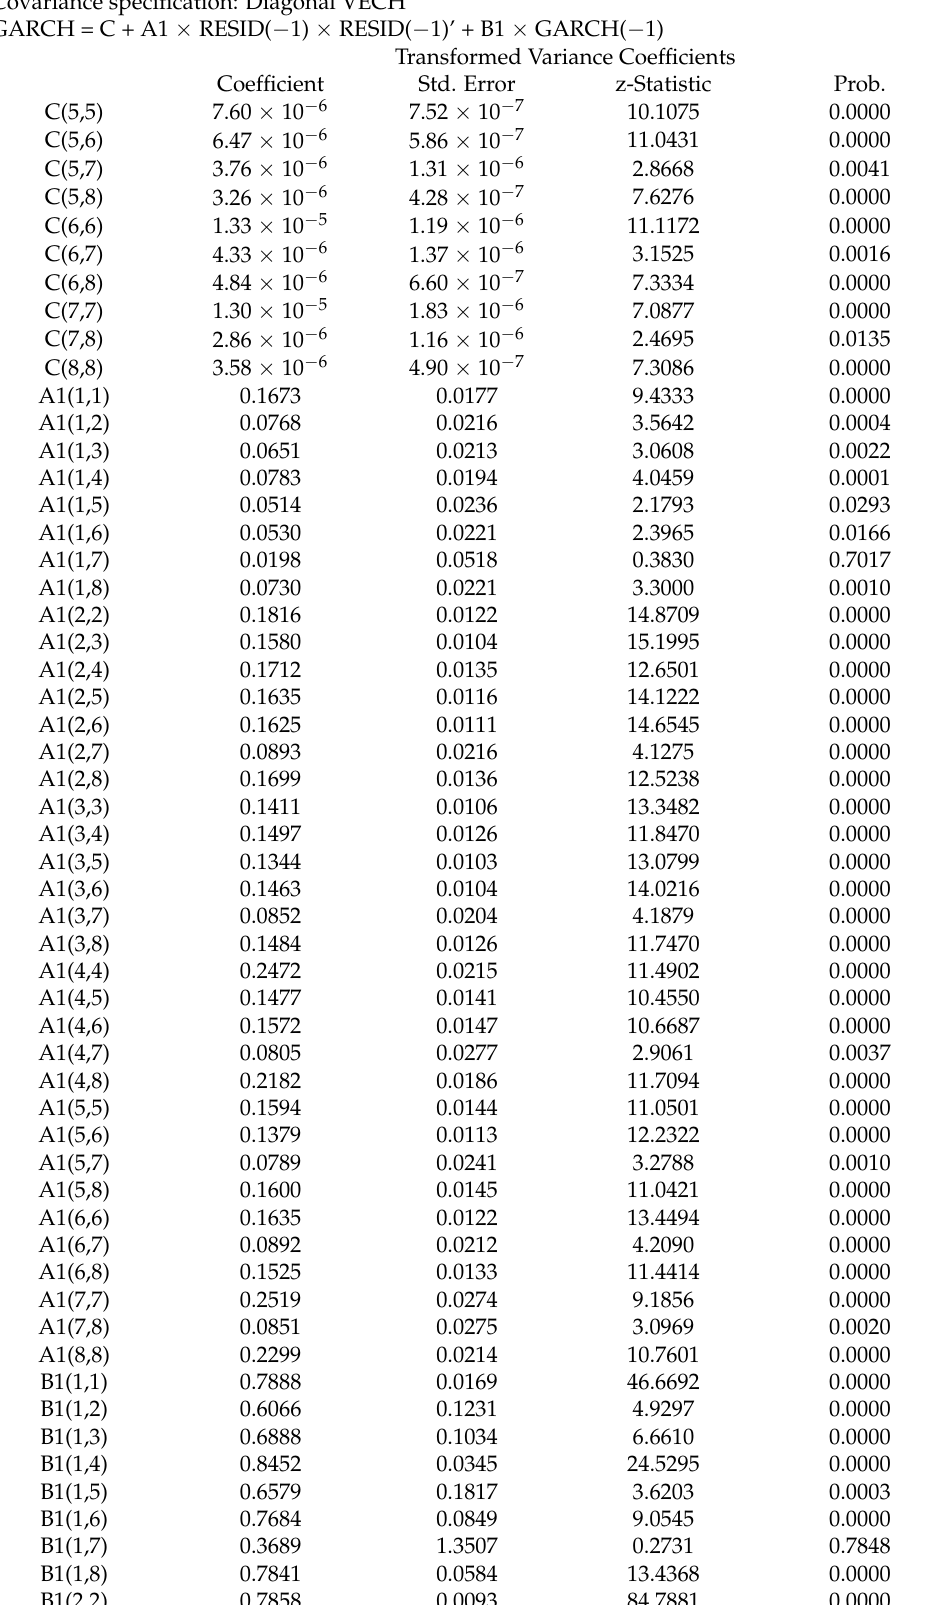
Table A1. Cont. Covariance specification: Diagonal